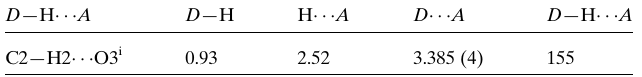
Table 1 Hydrogen-bond geometry (A˚ , (cid:2) ).